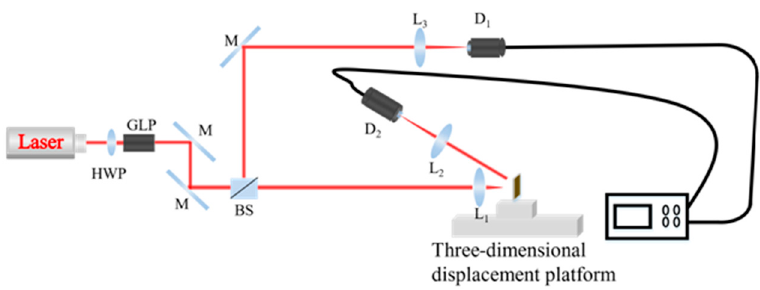
Figure 4. Optical path diagram of the optical bistability experiment.